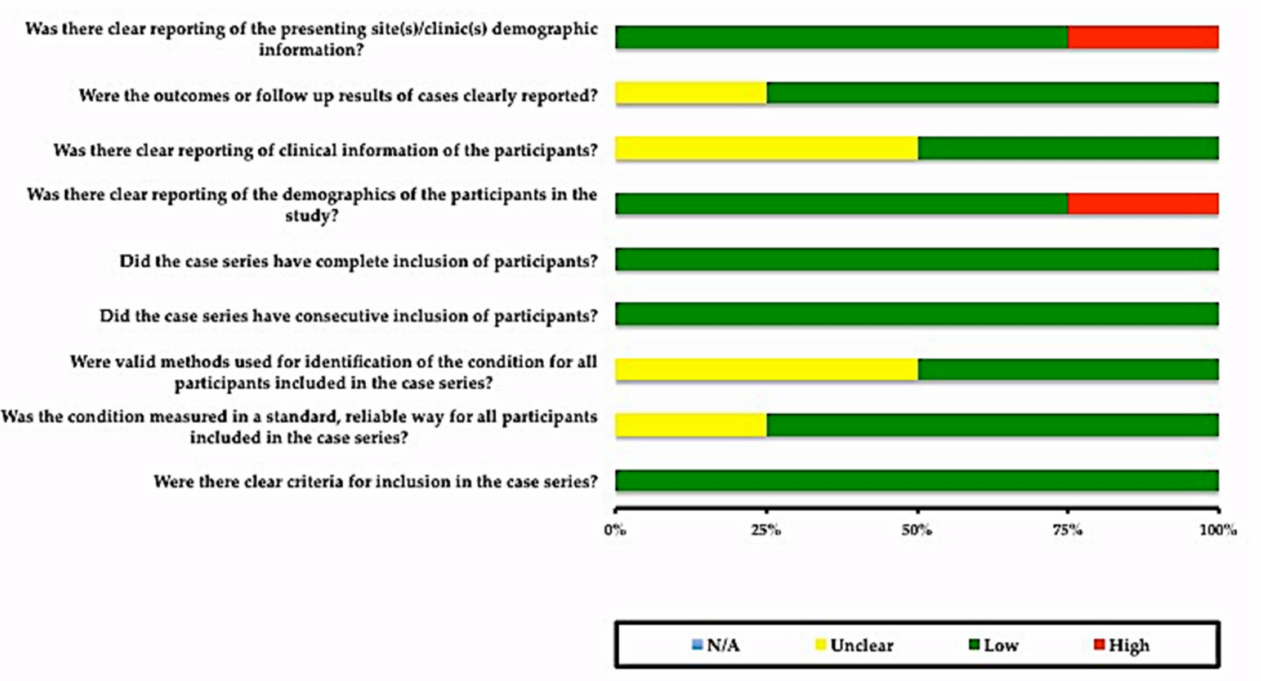
Figure 3. Risk of bias for the case